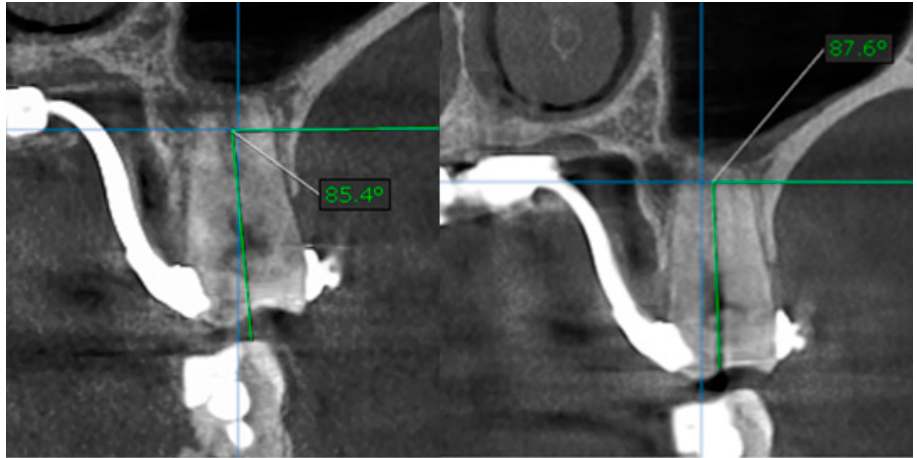
Figure 12. The first molar position before vs. after the palatal suture split.